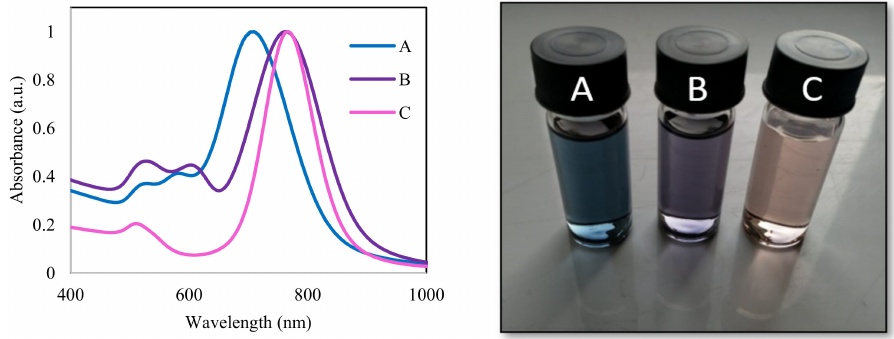
Figure 1. Normalized absorption spectra and corresponding picture of the studied anisotropic gold nanostructures ( A —off-resonance GNBs, B —on-resonance GNBs, C —on-resonance